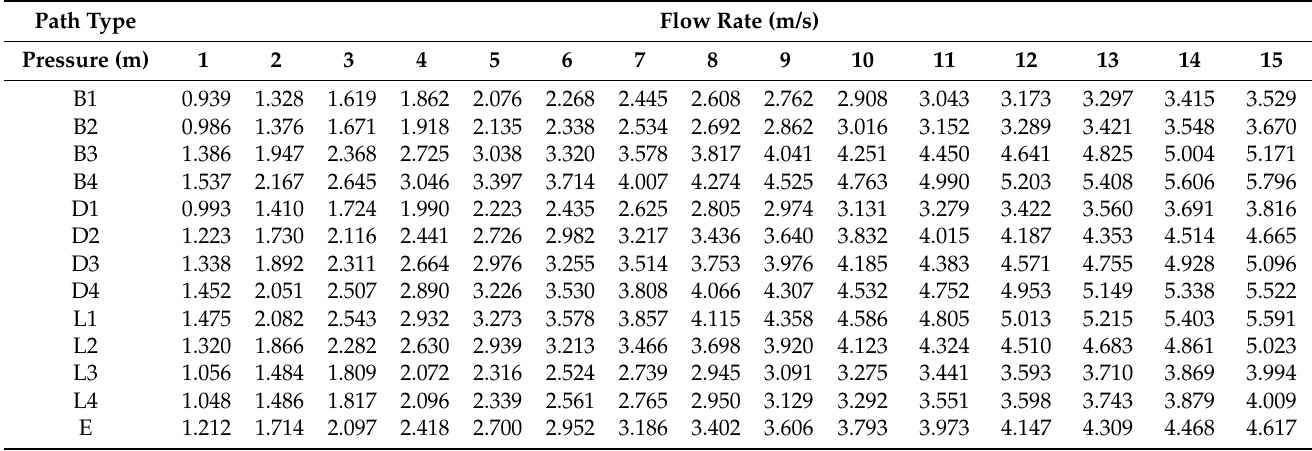
Table 3. Simulated flow values in the fractal flow path at different working